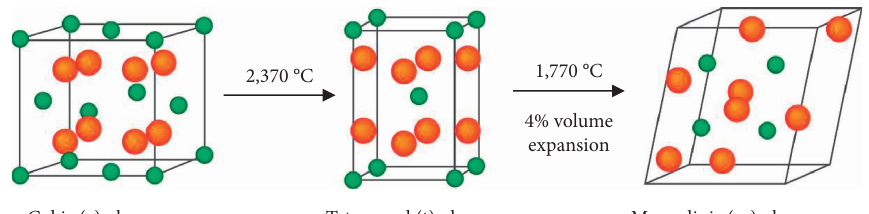
Figure 2: Phase transformation of zirconia.